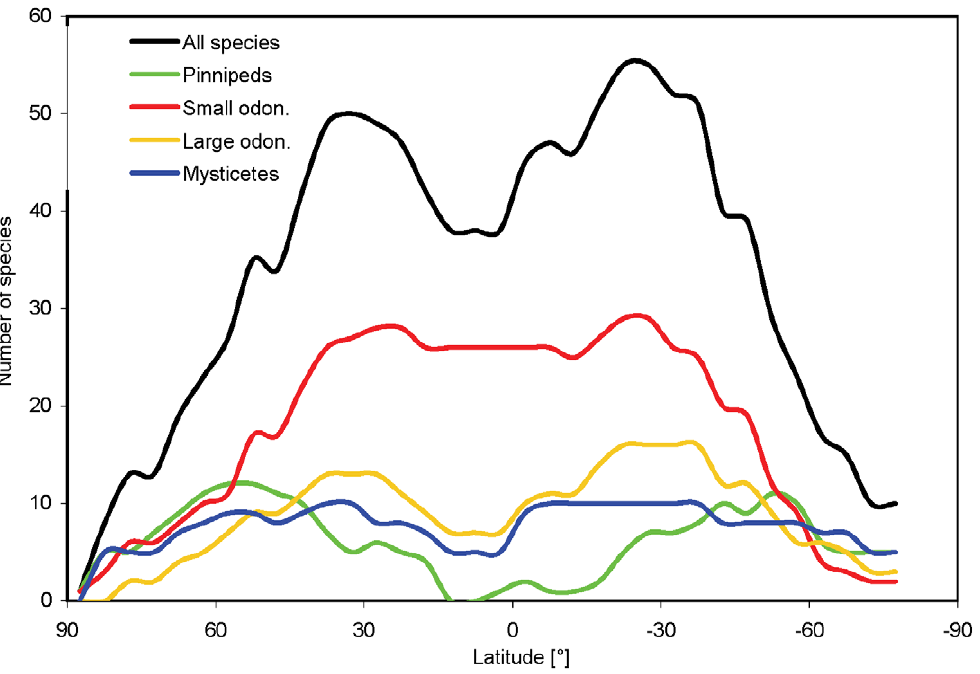
Figure 2. Marine mammal species richness by latitude. Number of predicted species was summed over 5 u latitudinal bands for all species, mysticetes, small odontocetes, large odontocetes (beaked whales and sperm whale), and pinnipeds.